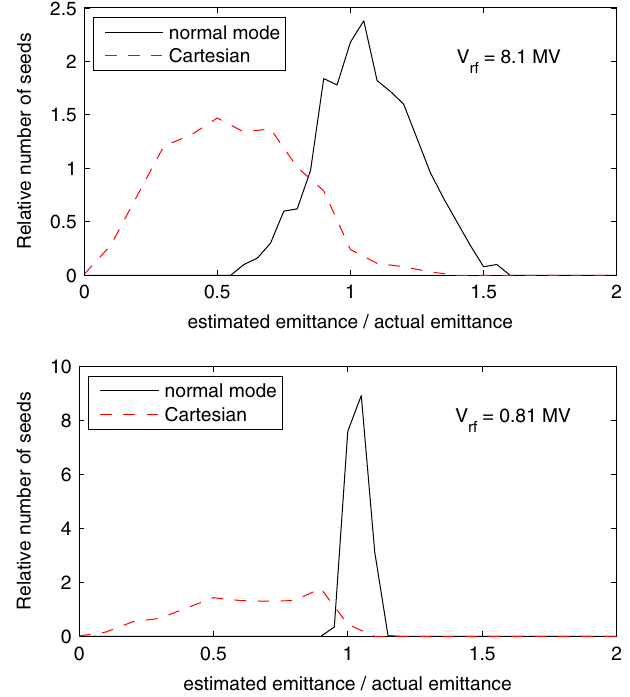
FIG. 5. Emittance estimated from dispersion in CesrTA with (top) 8.1 MV rf voltage, and (bottom) 0.81 MV rf voltage. The lines show the distribution (over 1000 seeds of machine errors) of the ratio of the estimated mode II emittance to the actual mode II emittance; the vertical axes are scaled so that each curve has unit area. In the normal mode case, the mode II dispersion is used, and the emittance estimated using Eq. (10). In the Cartesian case, a modified version of Eq. (10) is used, in which the mode II dispersion is replaced by the vertical dispersion in Eq. (12). In both cases, the exact emittance is calculated using the envelope method. The approximations involved in Eq. (10) are valid for small values of the synchrotron tune (which is 0.074 at 8.1 MV rf, and 0.023 at 0.81 MV